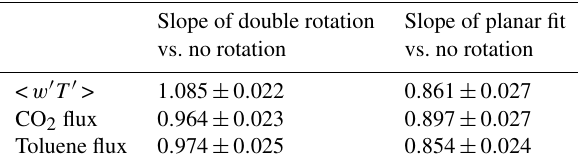
Figure 1. (a) Sonic anemometer tilt correction angles dependent on the mean wind direction. For each mean wind direction, all avail- able half-hour intervals of data with mean wind direction within ± 15 ◦ were taken for determining the tilt correction angles accord- ing to the planar fit method. The dashed lines show 95% confidence bounds estimated by bootstrapping. (b) The histogram shows the number of half-hour intervals contributing to the calculation of the correction angles. Table 1. Comparison of calculated fluxes using two different anemometer tilt correction methods with respect to no tilt correc- tion. Slopes are determined by a robust linear fit through corrected data vs. uncorrected data and include 95% confidence